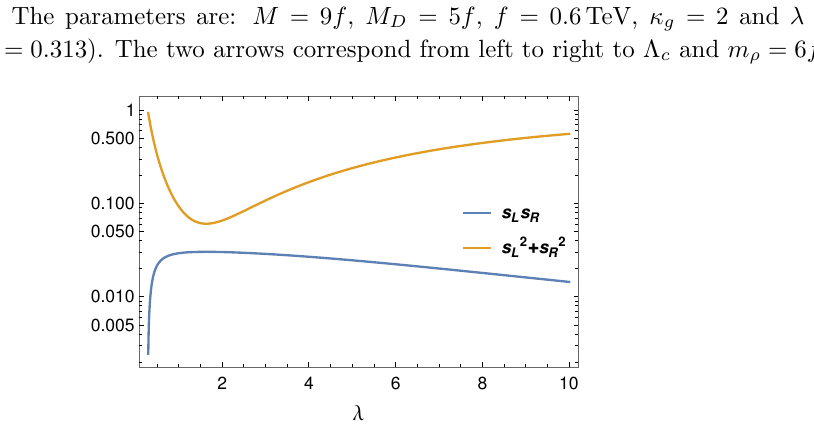
Figure 4 . Mixing angle dependence of the form factors f 1 ( s 2